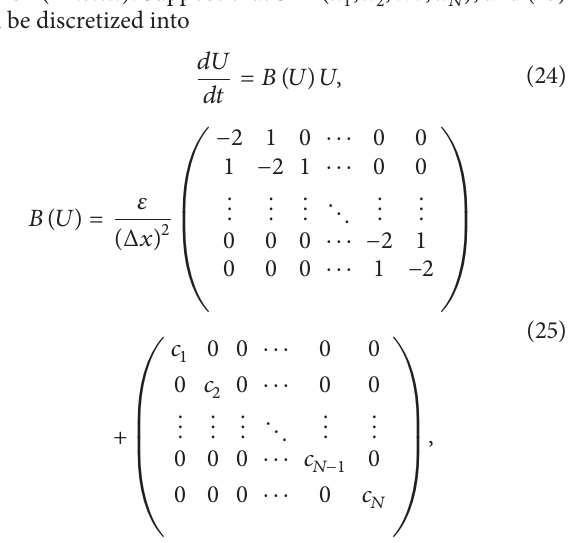
Table 2: The errors of the numerical solutions and the exact solutions at different times by ERK method and EEI method.